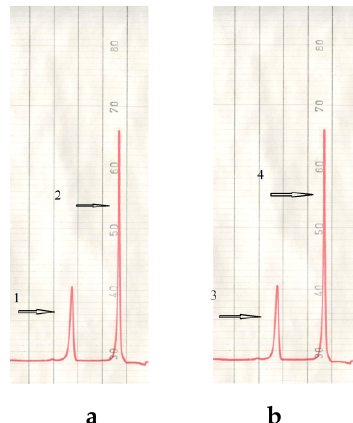
Figure 1. Typical chromatogram of adipic acid esters. ( a ) 1—dibutoxyethyl adipate, 2—decyl butoxyethyl adipate; ( b ) 3—diphenoxyethyl adipate, 4—decyl phenoxyethyl adipate.